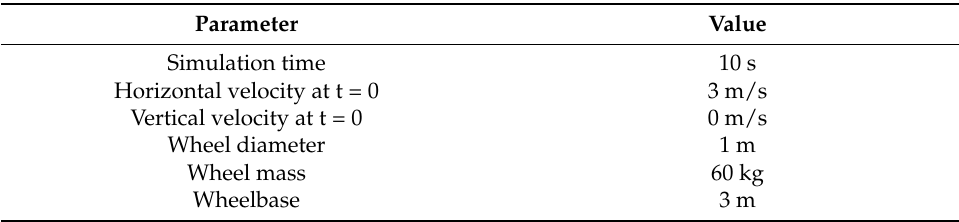
Table 1. Model parameters.